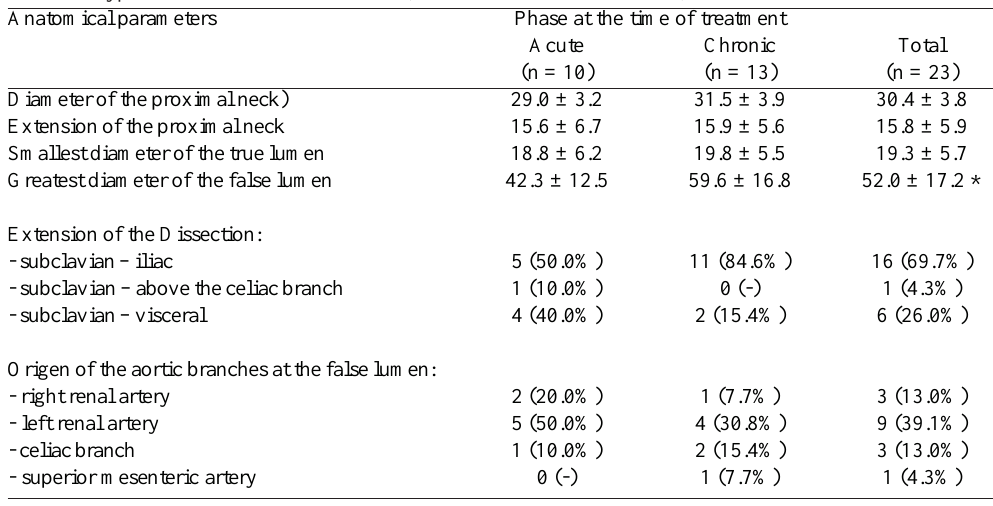
Table 4. Anatomical parameters of the 23 patients submitted to endovascular treatment of complicated